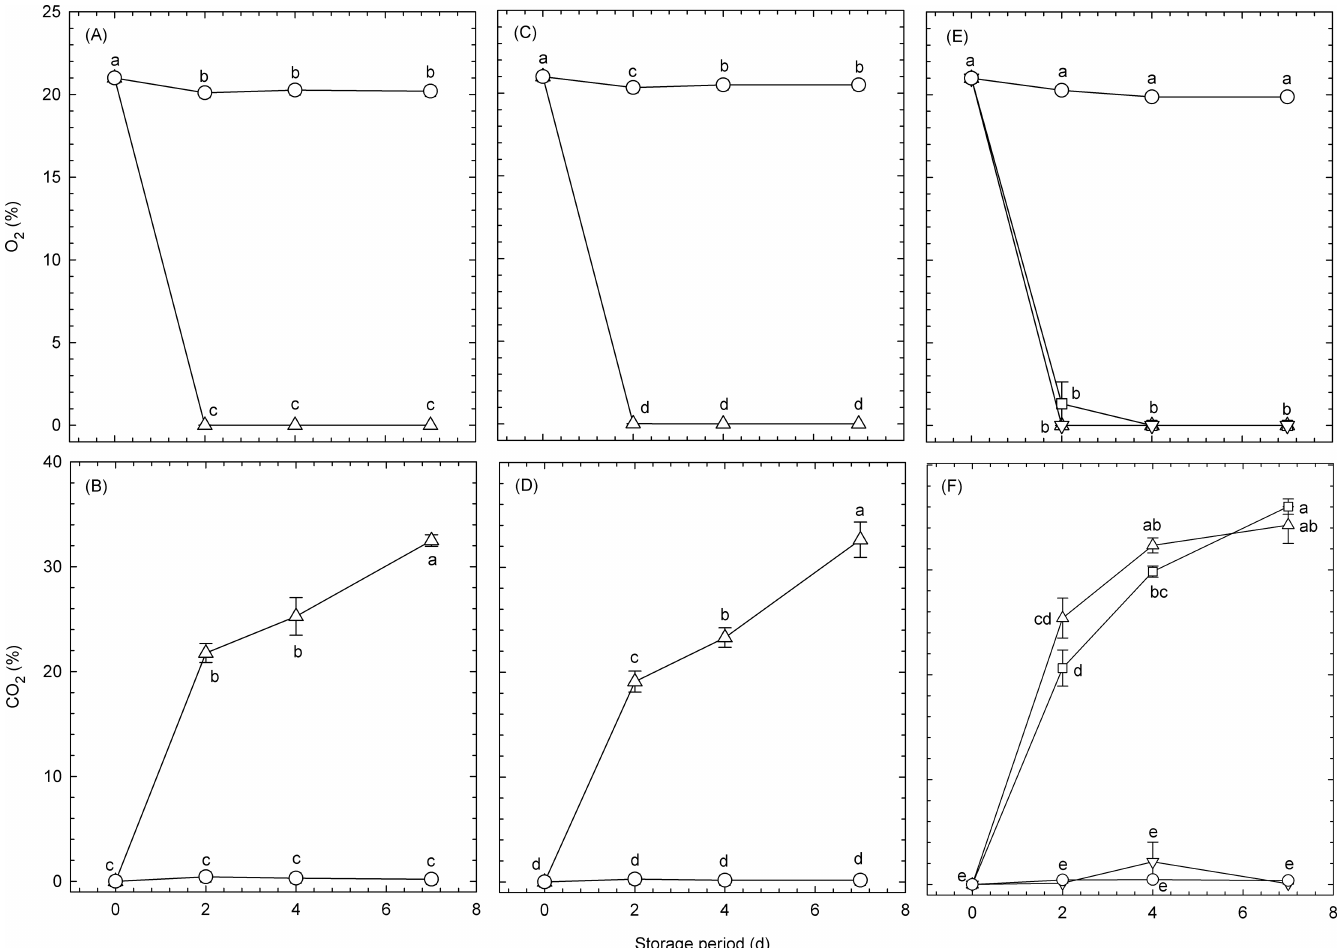
perforated pouches with O 2 transmission rates of 1.2 × 10 6 mL m −2 d −1 atm −1 (normoxia); upward-pointing triangles: high-barrier pouches with O 2 transmission rates of 8.0 mL m −2 d −1 atm −1 (hypoxia); downward-pointing triangles: high-barrier pouches with O 2 transmission rates of 8.0 mL m −2 d −1 atm −1 and including CO 2 absorbers; squares (hypoxia): micro-perforated pouches with O 2 transmission rates of 64.0 mL m −2 d −1 atm −1 (hypoxia). Values are the means ± SE of three observations from three different biological samples. Symbols followed by the same letter within the same figure indicate that there were no significant differences ( p < 0.05, Tukey’s honest difference